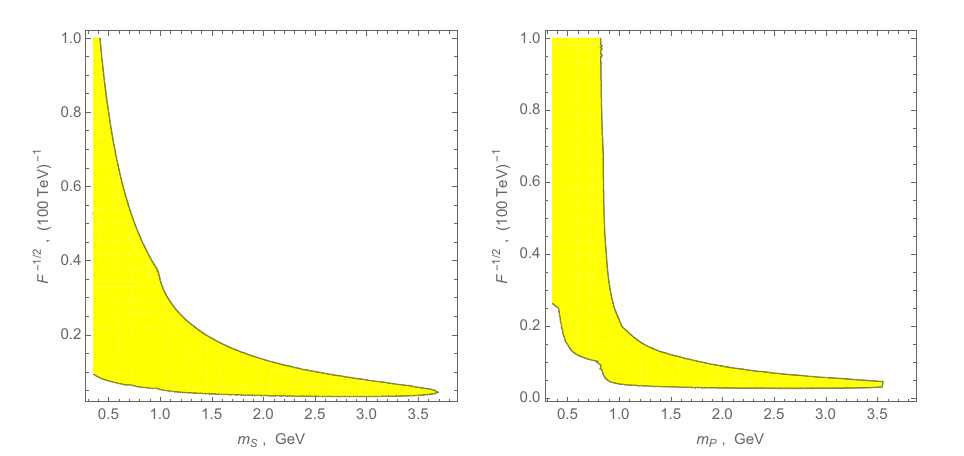
Figure 3. The shaded region will be probed at the SHiP experiment. Left plot is for probing scalar sgoldstino and right is for